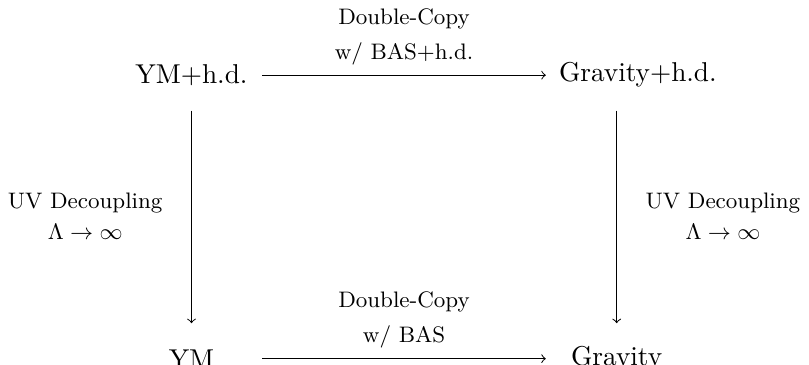
Figure 1 . Illustration of the physical meaning of the perturbative double-copy. Physics at the UV scale Λ decouples in both the single- and double-copies as Λ → ∞ (i.e. this diagram commutes) only if the rank of the higher-derivative corrected BAS is the same as the rank of the uncorrected